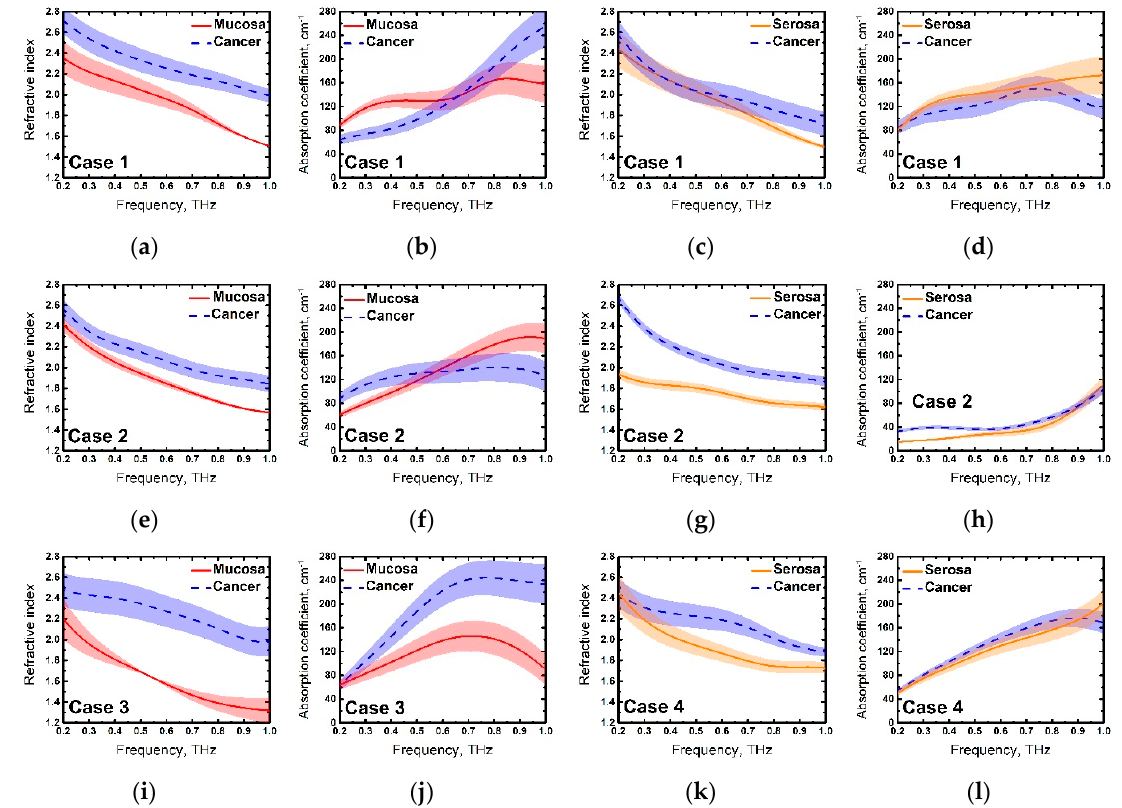
Figure 5. Refractive index and absorption coefficient of mucous, serous gastric fresh tissues, and cancer localized in both mucous and serous membranes of the stomach: ( a – d ) Case 1; ( e – h ) Case 2; ( i , j ) Case 3; and ( k , l ) Case 4.